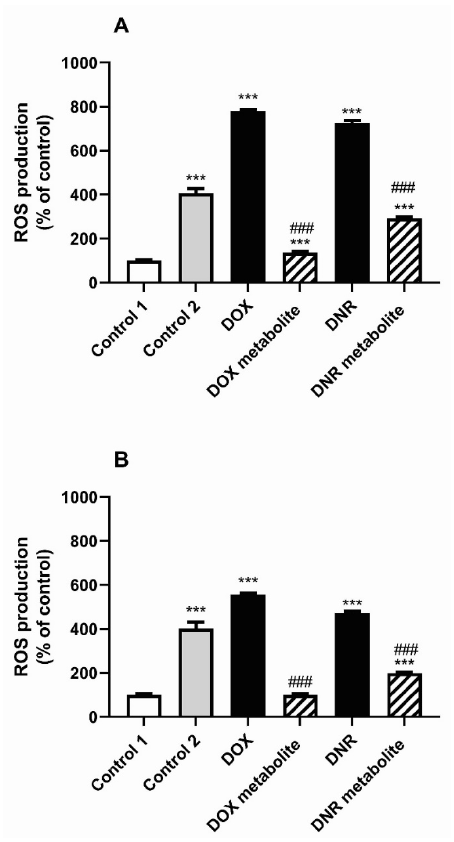
Figure 4. The effect of conditioned media on the ROS production after 24 h ( A ), and 48 h ( B ) in BJ fibroblasts: *** p < 0.001 versus the control 1 cultures. ### p < 0.001 versus the cell espoused to medium before conditioning. Control 1—cell culture medium with PBS, Control 2—cell culture medium with Park Robinson medium for fungi culture, DOX—cell culture medium with doxorubicin, DOX metabolite—cell culture medium with doxorubicin after fungi culture, DNR—cell culture medium with daunomycin, DNR metabolite—cell culture medium with daunomycin after fungi culture.